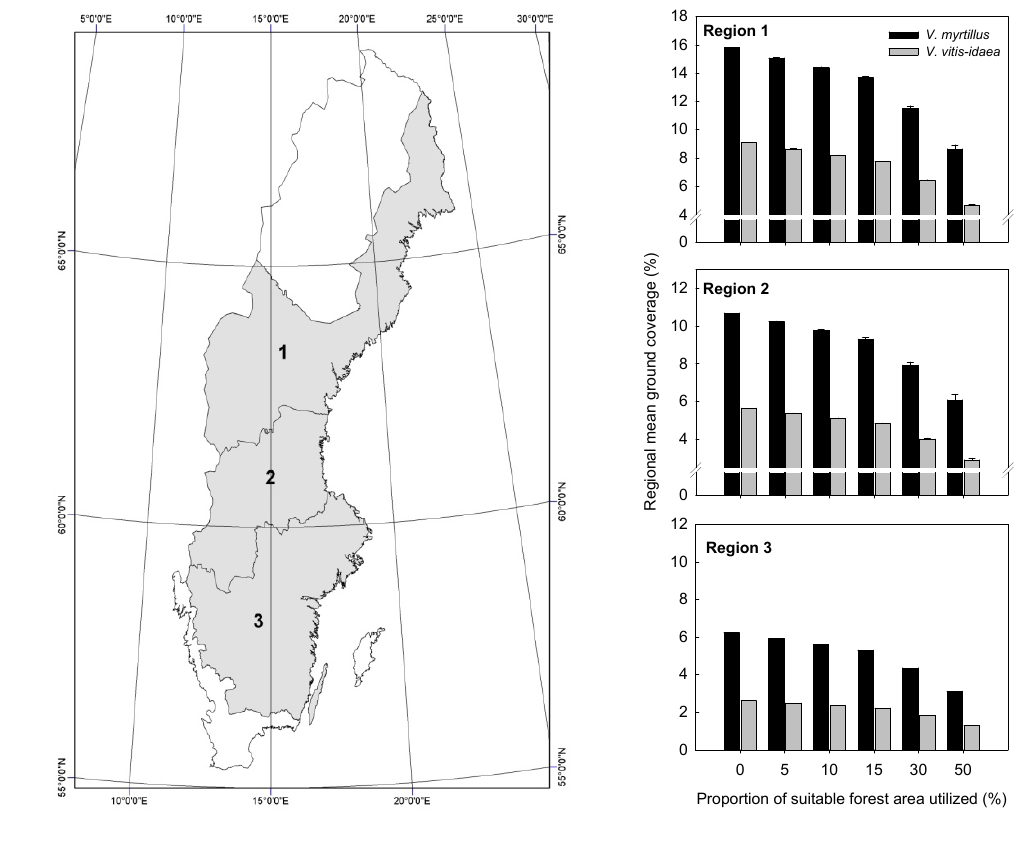
Figure 2. Changes in regional ground coverage for V. myrtillus and V. vitis-idaea in relation to the proportion of land converted into plantations. Zero percent utilization represents the current regional mean values. Changes in ground cover are presented for three regions of Sweden: ( 1 ) North Sweden, ( 2 ) South-central Sweden, and ( 3 ) South Sweden. Changes are based on current differences in regional cover and the predicted cover if the given proportion of land is utilized for intensive fertilization. Error bars represent 95% confidence